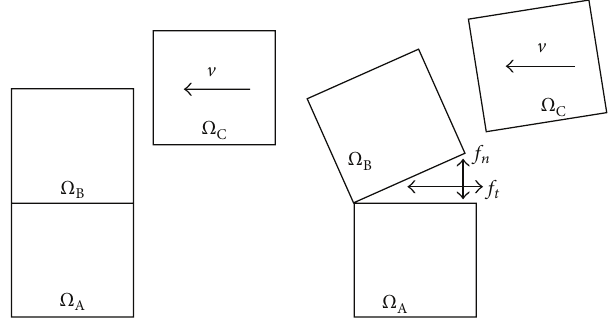
Figure 1: Detachment of the blocks due to impact.